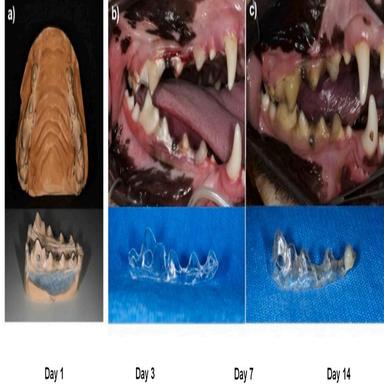
Method and results of animal study. a) Dental casts of maxillary and mandibular arches (top), and Fabrication of VFCs (bottom). b) Delivery of VFCs (additional resin bonding and orthodontic miniscrew installation was performed for retention). c) Removal of VFCs on day 14. Representative images of canine oral bacterial biofilms formed on outer (d, f, h, j) and inner (e, g, i, k) surfaces of the specimens after animal experiment. The oral biofilms were established for 1, 3, 7 and 14 days. Two images (uncoated